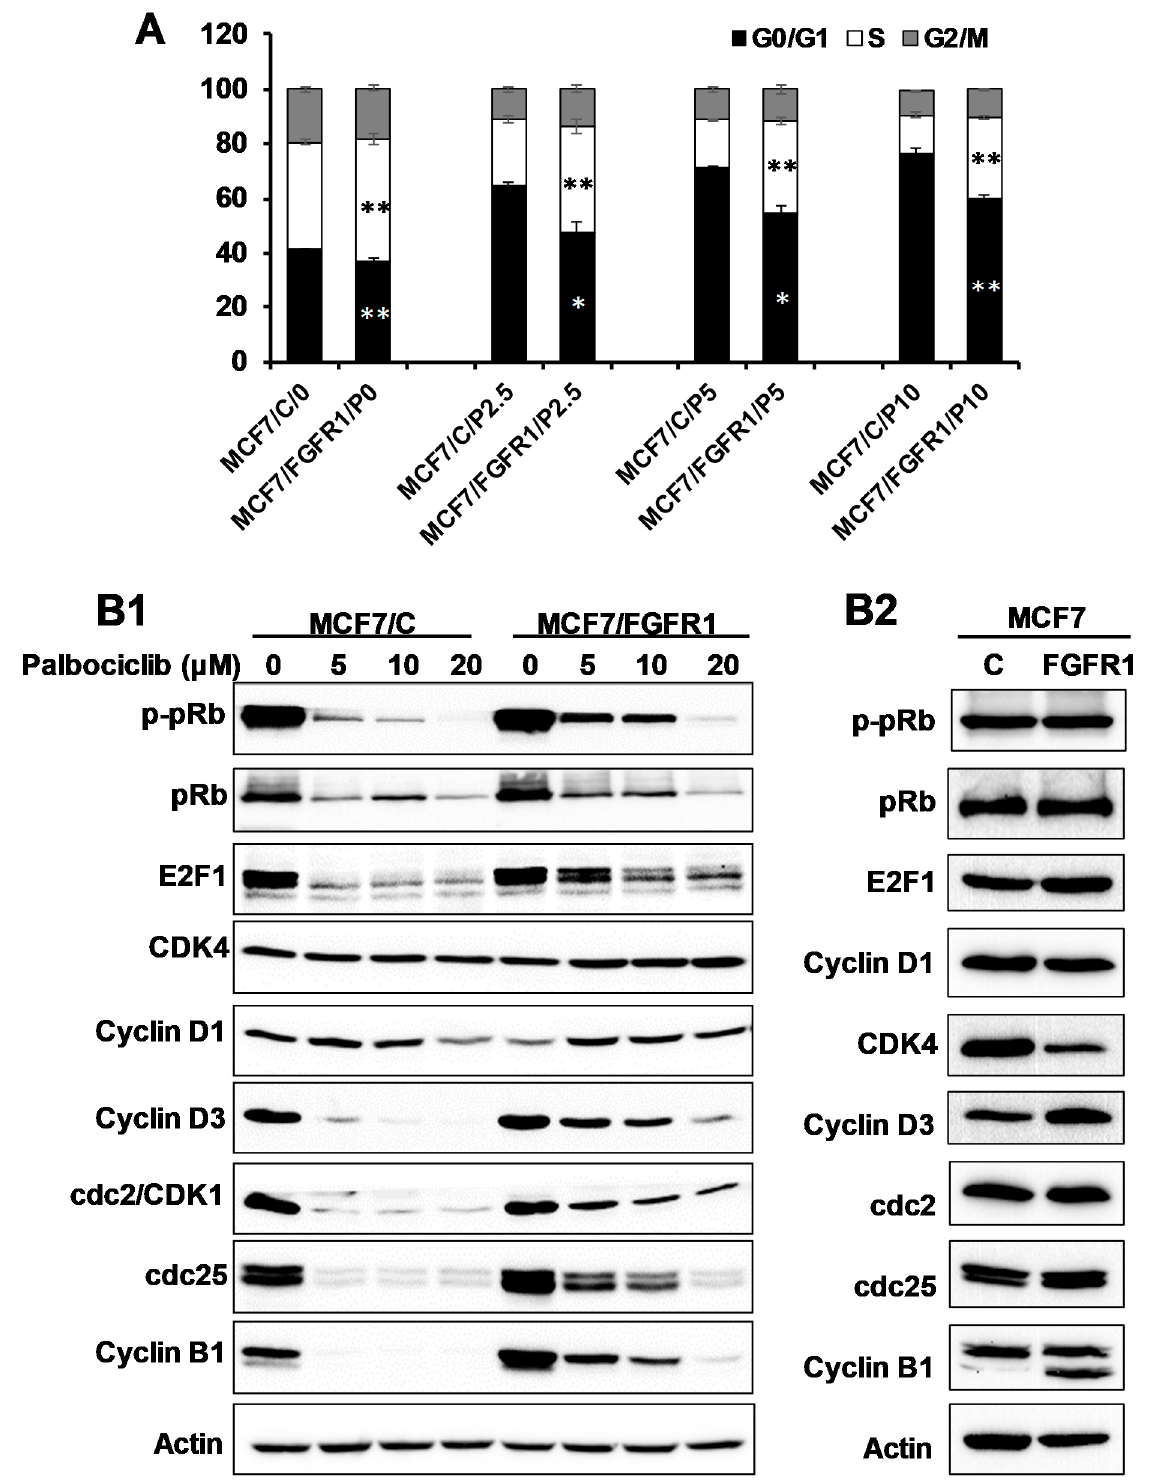
Figure 2. Effect of FGFR1 overexpression on palbociclib-induced inhibition of cell cycle progression and cell cycle regulators. ( A ) MCF-7/C and MCF-7/FGFR1 cells were treated with palbociclib (0, 2.5, 5, 10 μ M) for 24 h, followed by cell cycle analysis. Cells in different phases were analyzed with ModFit software. (** p < 0.01, * p < 0.05 vs. corresponding phases of control cells). Data from triplicate samples were reported. ( B1 ) Western blot detection of key cell cycle regulators regulated by palbociclib. MCF-7/C and MCF-7/FGFR1 cells were treated with palbociclib, at the indicated concentrations, for 48 h, followed by Western blot analysis of specified markers. ( B2 ) Protein levels of key markers in ( B1 ) in MCF-7/C and MCF-7/FGFR1 cells in the absence of